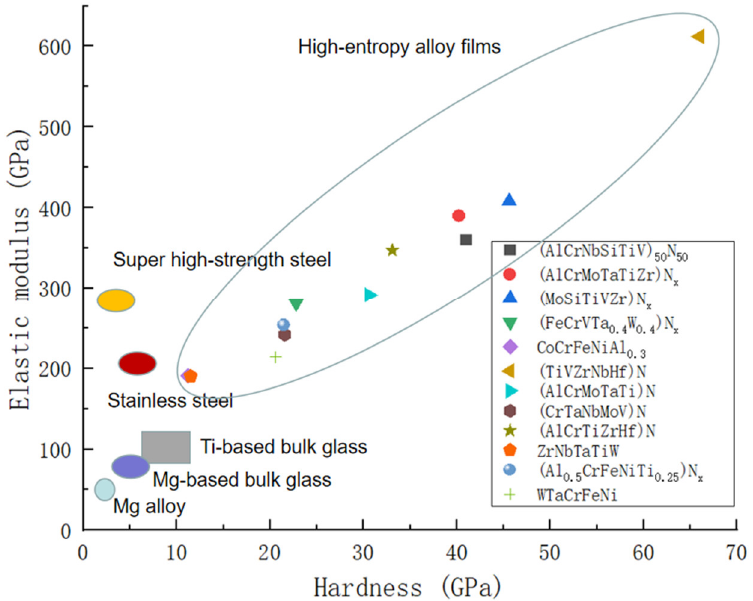
Figure 6. Relationship between hardness and elastic modulus for common alloys and high-entropy alloy films.